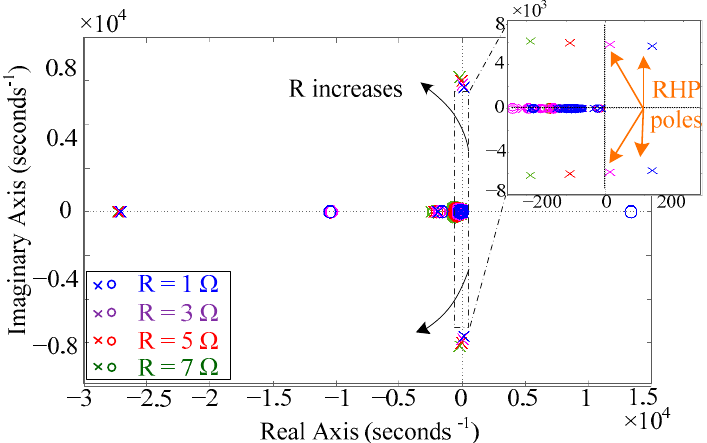
Figure 14. Pole-zero map of G icq _cl_dr ( s ) with filter resistors. Although adding extra resistors is effective, the associated power loss deteriorates system efficiency. Therefore, an active control scheme is further proposed to mimic the behavior of filter resistors. The proposed virtual resistance control scheme is shown in Figure 15, where G ad (s) and G aq (s) stand for the proposed controllers on the d -axis and q -axis, respectively.